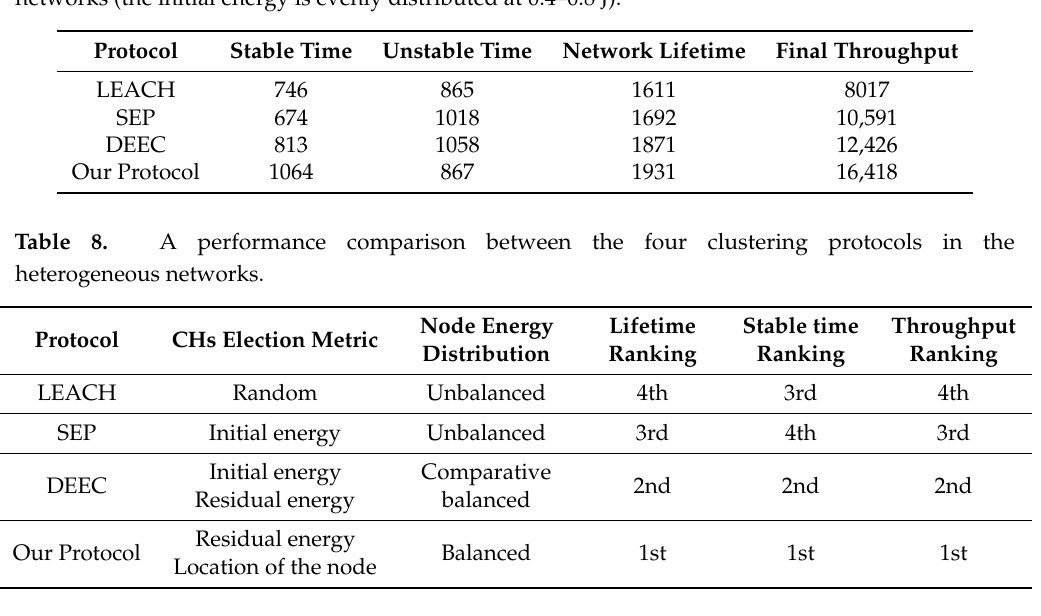
Table 7. A performance comparison between the four clustering protocols in the homogeneous networks (the initial energy is evenly distributed at 0.4–0.8 J).